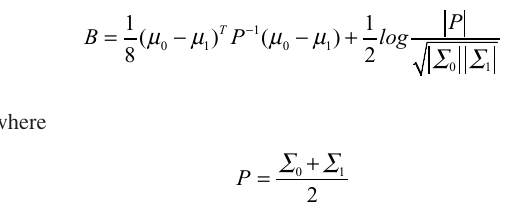
Figshare: Supplementary audio files for ‘Chromas from chromatin: sonification of the epigenome’, doi: 10.6084/m9.figshare.3079540 30 Figshare: Supplementary table for ‘Chromas from